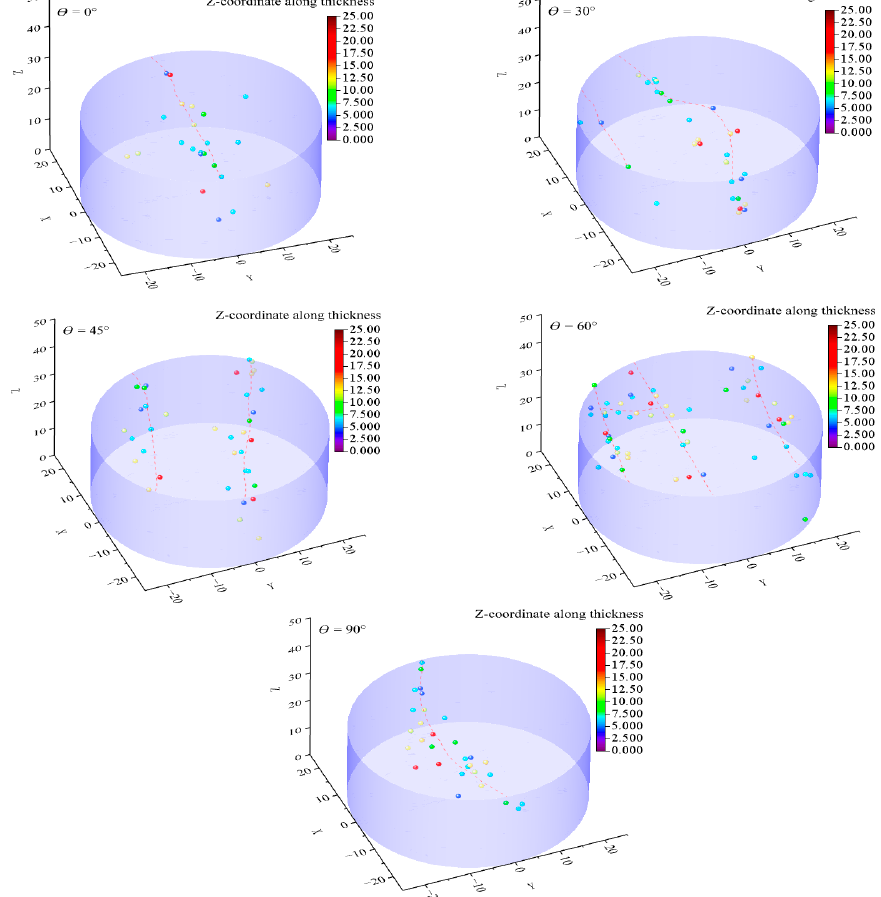
Figure 11. AE signal spatial distribution characteristics with different layer orientations.